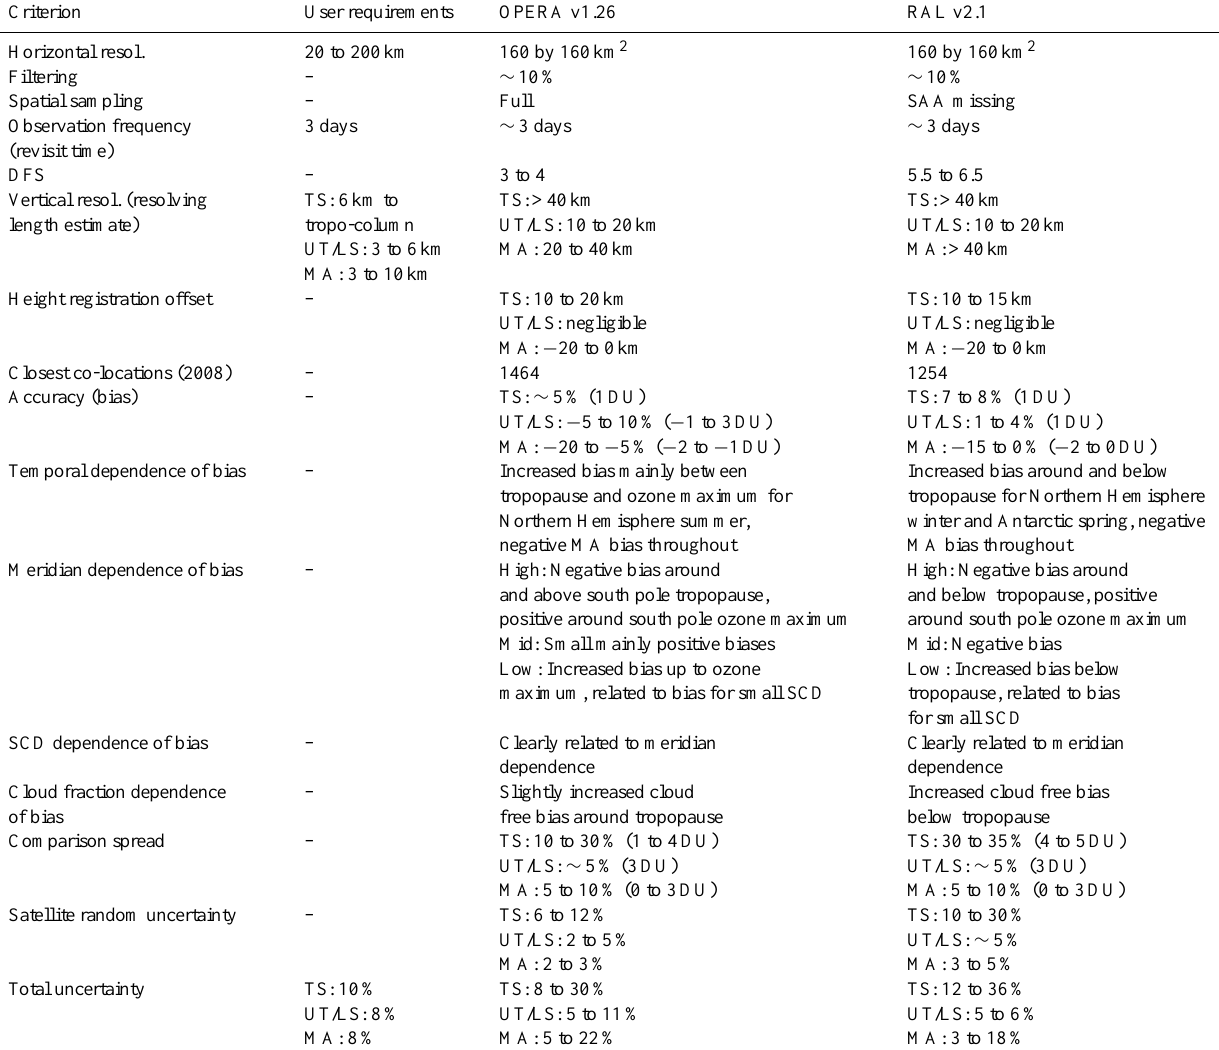
Table 4. Overview of nadir ozone profile round-robin evaluation criteria and their corresponding OPERA and RAL outcome for GOME-2 (2008). Where possible, results have been differentiated between troposphere (TS), UT/LS, and middle atmosphere (MA). Criterion Horizontal